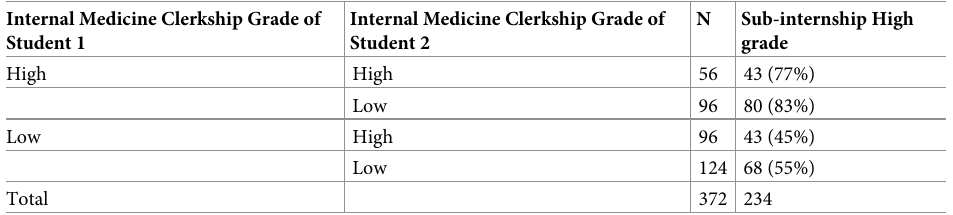
Table 3. Sub-internship high grades by internal medicine clerkship